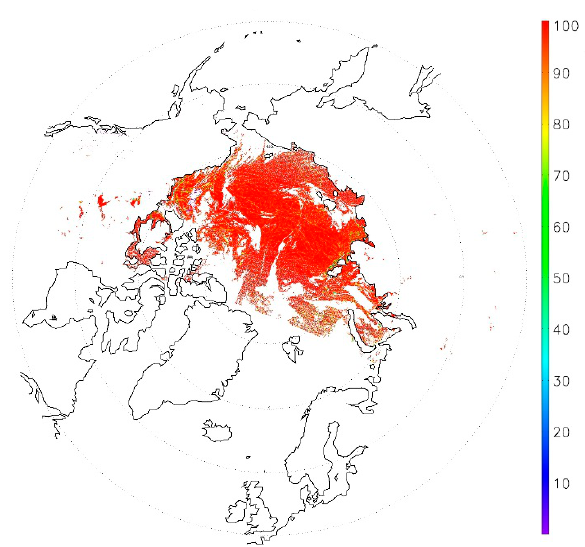
Figure 7. Ice concentration over the Arctic Ocean from the VIIRS overpass 8:43 p.m. to 9:03 p.m. UTC on 20 February 2015. The cloud-covered areas are white.